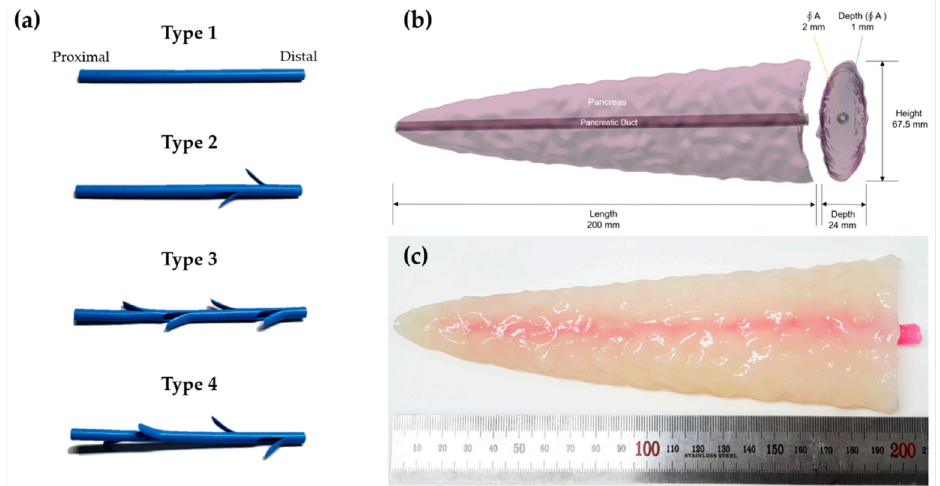
Figure 2. Types of plastic stents (PSs) with or without flaps and 3D-printed pancreatic phantom with the pancreatic duct (3DP) model. ( a ) The tubular structure with or without flaps was 2 mm in diameter and 30 mm in length. Each flap was 2 mm in length and projected 60 ◦ toward the papilla. ( b ) Photographs of modeling and specification. ( c ) Photographs of a 3DP